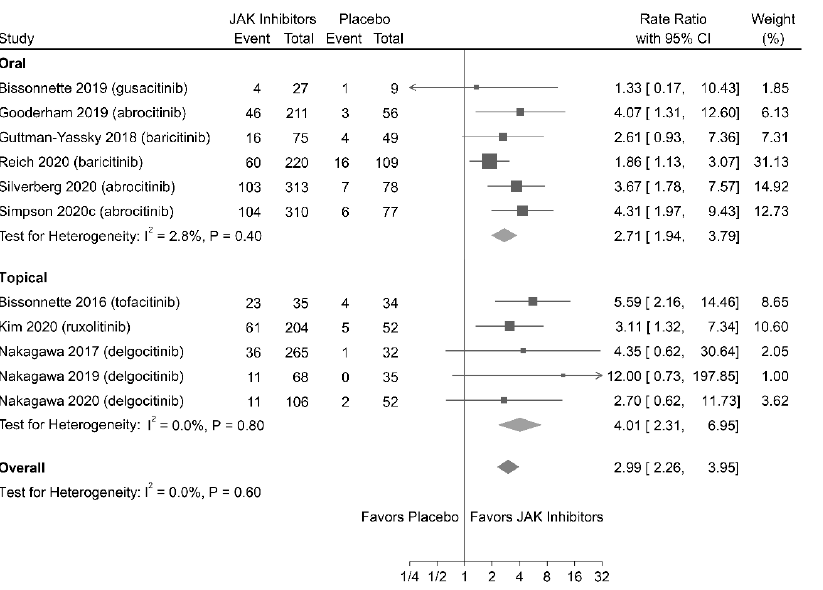
Figure 2. Association of Janus kinase (JAK) inhibitors versus placebo achieving of an Investigator Global Assessment (IGA) of 0 (clear) or 1 (almost clear) with at least a two-point reduction from the baseline (IGA response). CI, confidence interval.